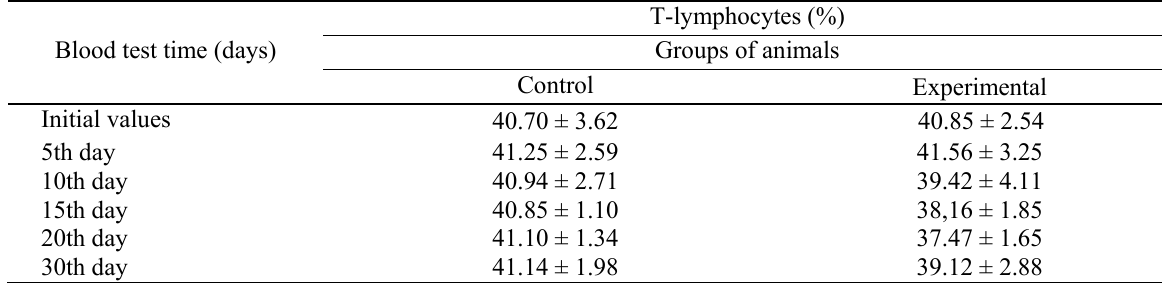
The number of T-lymphocytes in the blood of bulls under the influence of chronic cadmium toxicosis (М ± m, n = 5)